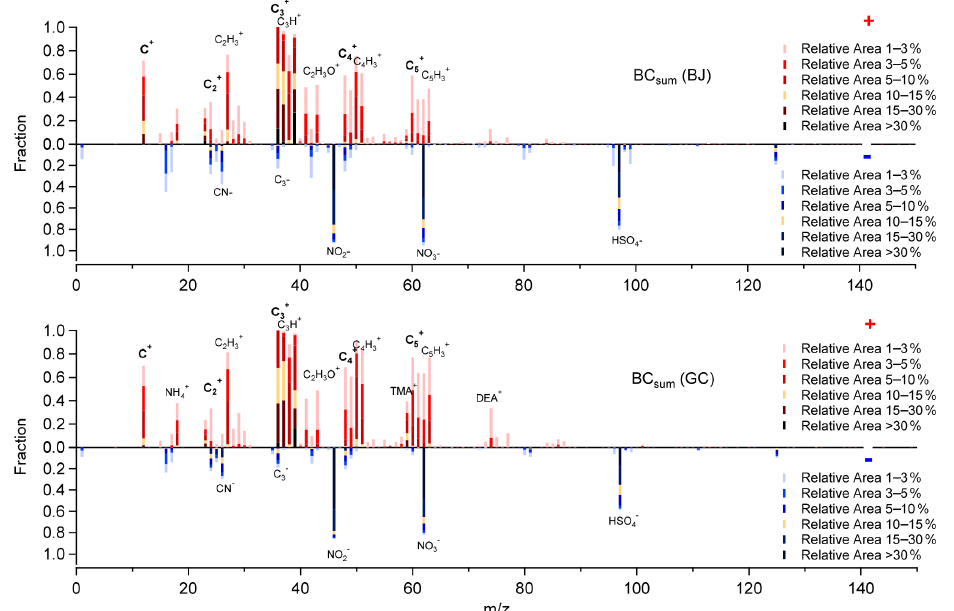
Figure 1. Digital positive and negative mass spectra of BC-containing particles in Beijing and Gucheng. The ion height indicates its number fraction in the BC-containing dataset (i.e., the number ratio of BC-containing particles with the corresponding ion detected in the mass spectra to the total BC-containing particles). The color bars represent each relative peak area corresponding to a specific fraction in the individual particles.